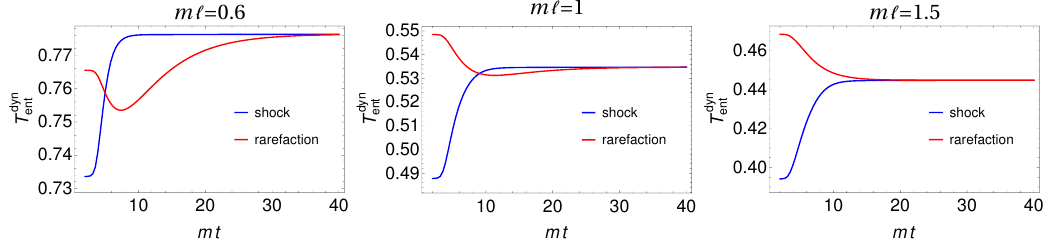
Figure 19: Dynamical entanglement temperature for (cid:96) = 0.6 (left), (cid:96) = 1 (middle) and (cid:96) = 1.5 (right) as function of time, all for the the NESS with χ = (cid:112) E / E = 9 / C H